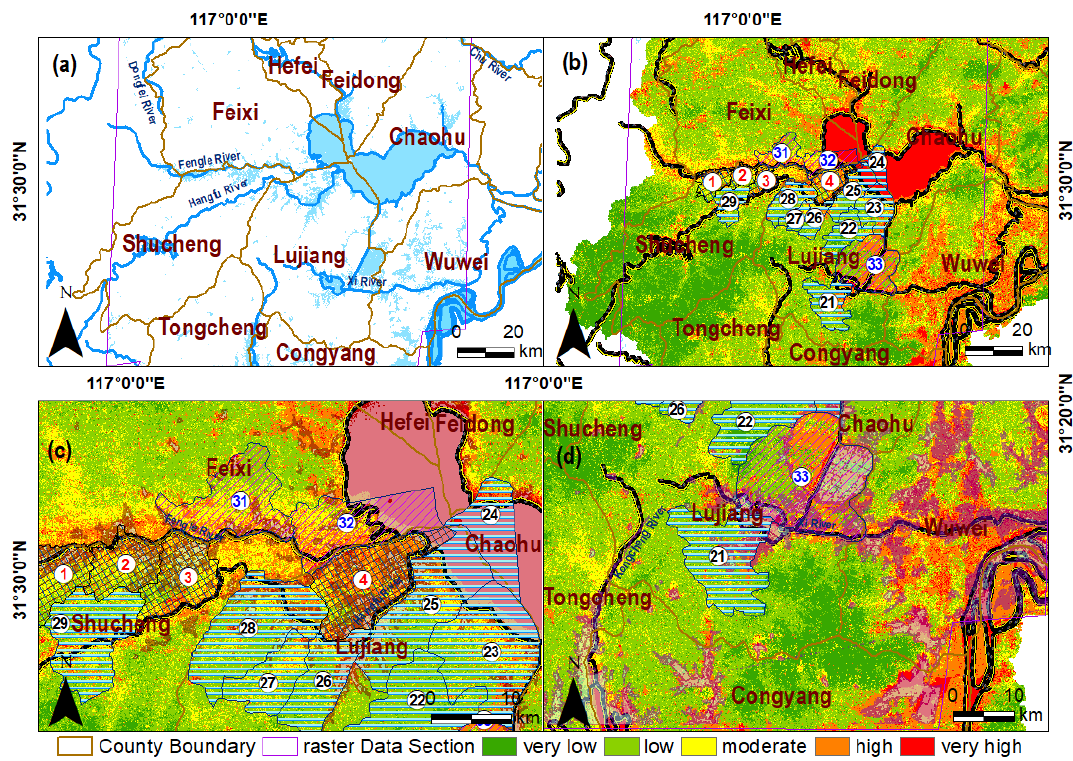
Figure 5. The flood hazard distribution is derived from the proposed method. Subfigure ( a ) was the real-world flooded areas extracted by remote sensing in July 2020 in the Chaohu basin. Subfigure ( b ) was the flood hazard distribution estimated by the proposed model. Subfigure ( c ) was the detailed hazard view of the Fengle river and the Hangfu River, and subfigure ( d ) was the clear hazard view of the Xi River.